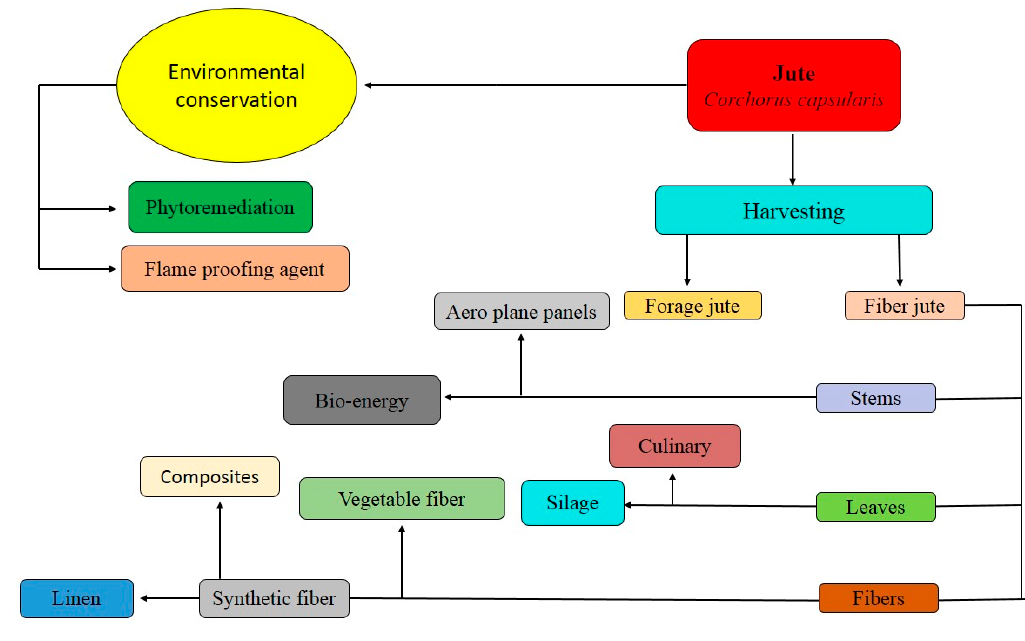
Figure 2. The flow chart diagram of jute and its uses.